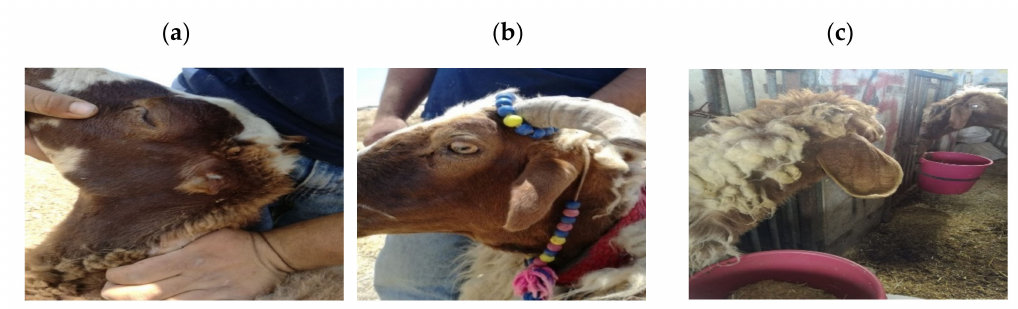
Figure 1. Ear types of Awassi sheep. ( a ) Earless, ( b ) short and ( c )